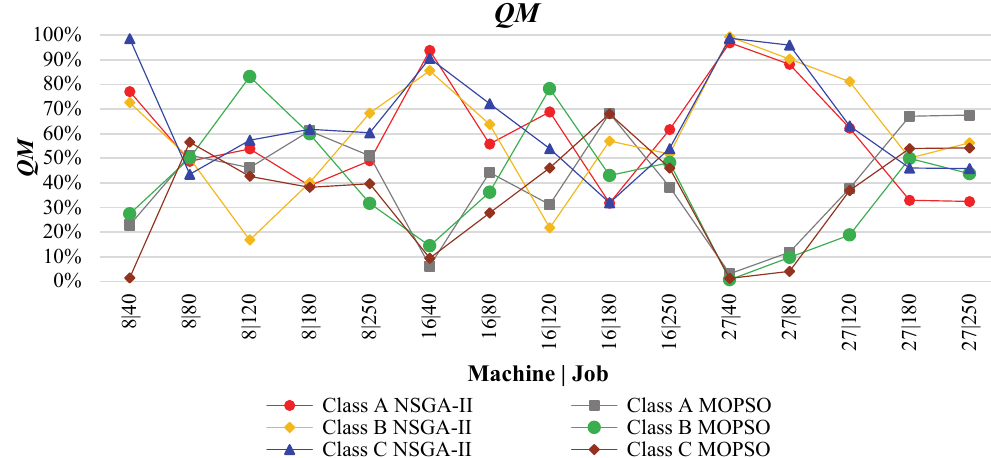
Fig. 17 QM criterion for the two algorithms in the medium and large scale sample